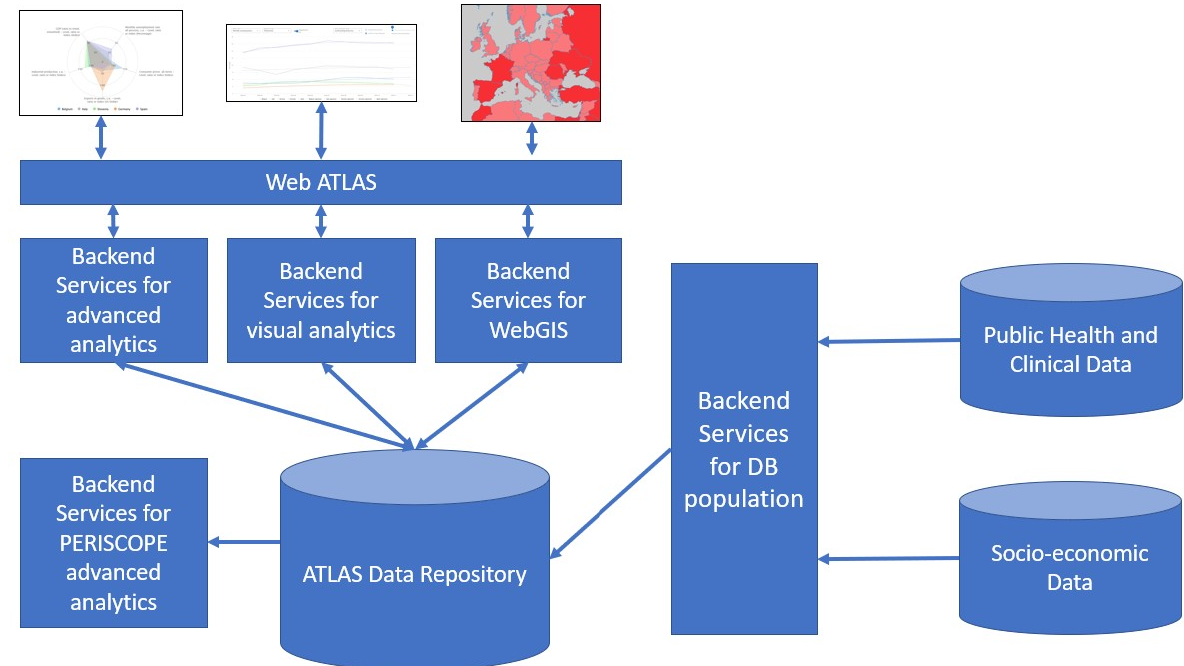
Figure 2. Data collection, integration and elaboration process in the PERISCOPE Atlas.